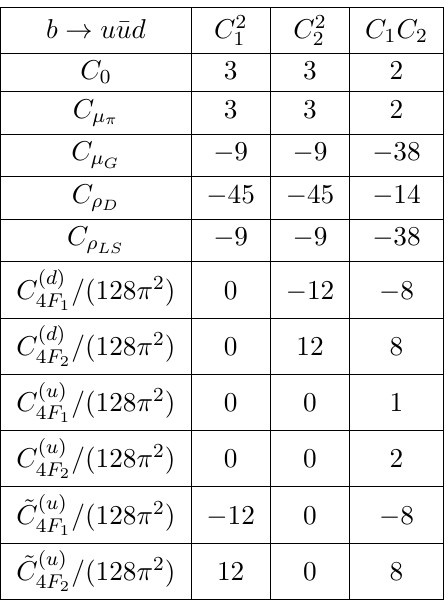
Table 1 . Numerical values for the coefficients of b → u ¯ ud .